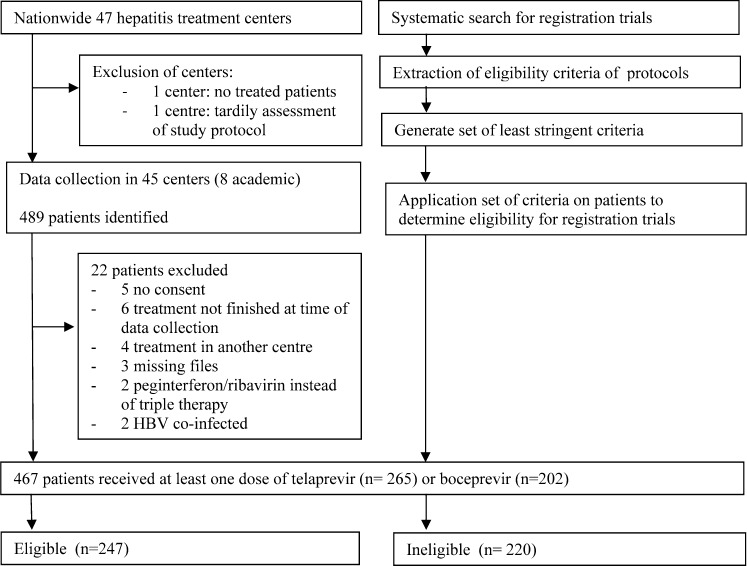
Study flowchart.The flowchart shows both enrollment of patients in all centers and assessment of eligibility for registration trials in this study.